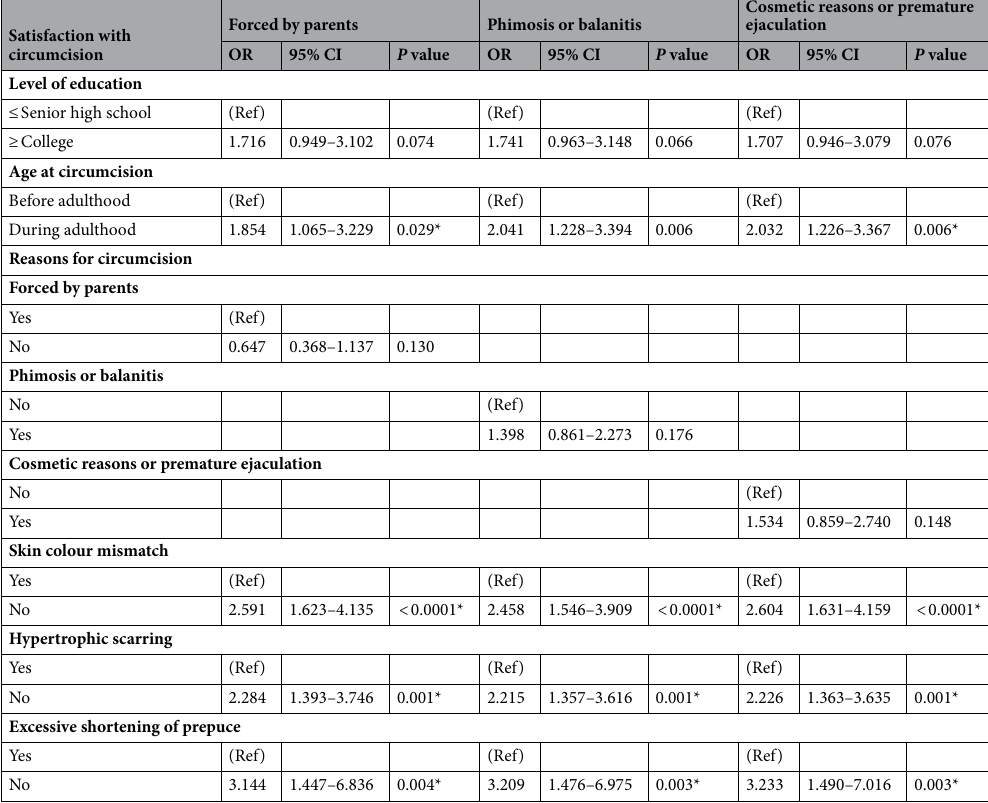
Table 3. Patient satisfaction based on reasons for circumcision after controlling for level of education, age at circumcision, and long-term complaints. OR odds ratio, CI confidence interval. * P < 0.05.